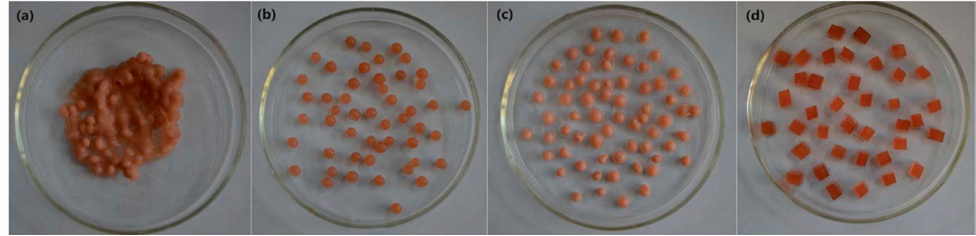
Figure 12. Digital images of the 4 types of immobilized granules ( a ) PVA ( b ) SA ( c ) PVA–SA ( d ) WPU [47]. Copyright © (2015) Royal Society of